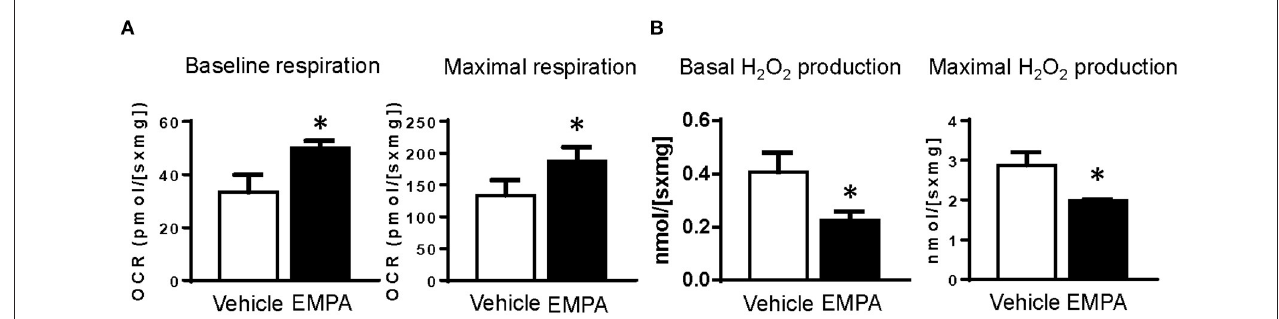
FIGURE 6 | Acute treatment of hearts from TAC groups with EMPA improved mitochondrial function. (A) Baseline and maximal oxygen consumption rate in heart tissues treated with vehicle or EMPA. (B) Baseline and maximal peroxide production in heart tissues treated with vehicle or EMPA. Results are expressed as mean ± SEM, n = 7, * p < 0.05 vs. vehicle group. Student t test. EMPA, empagliflozin; SEM, standard error of the mean; TAC, transverse aortic constriction; OCR, oxygen consumption